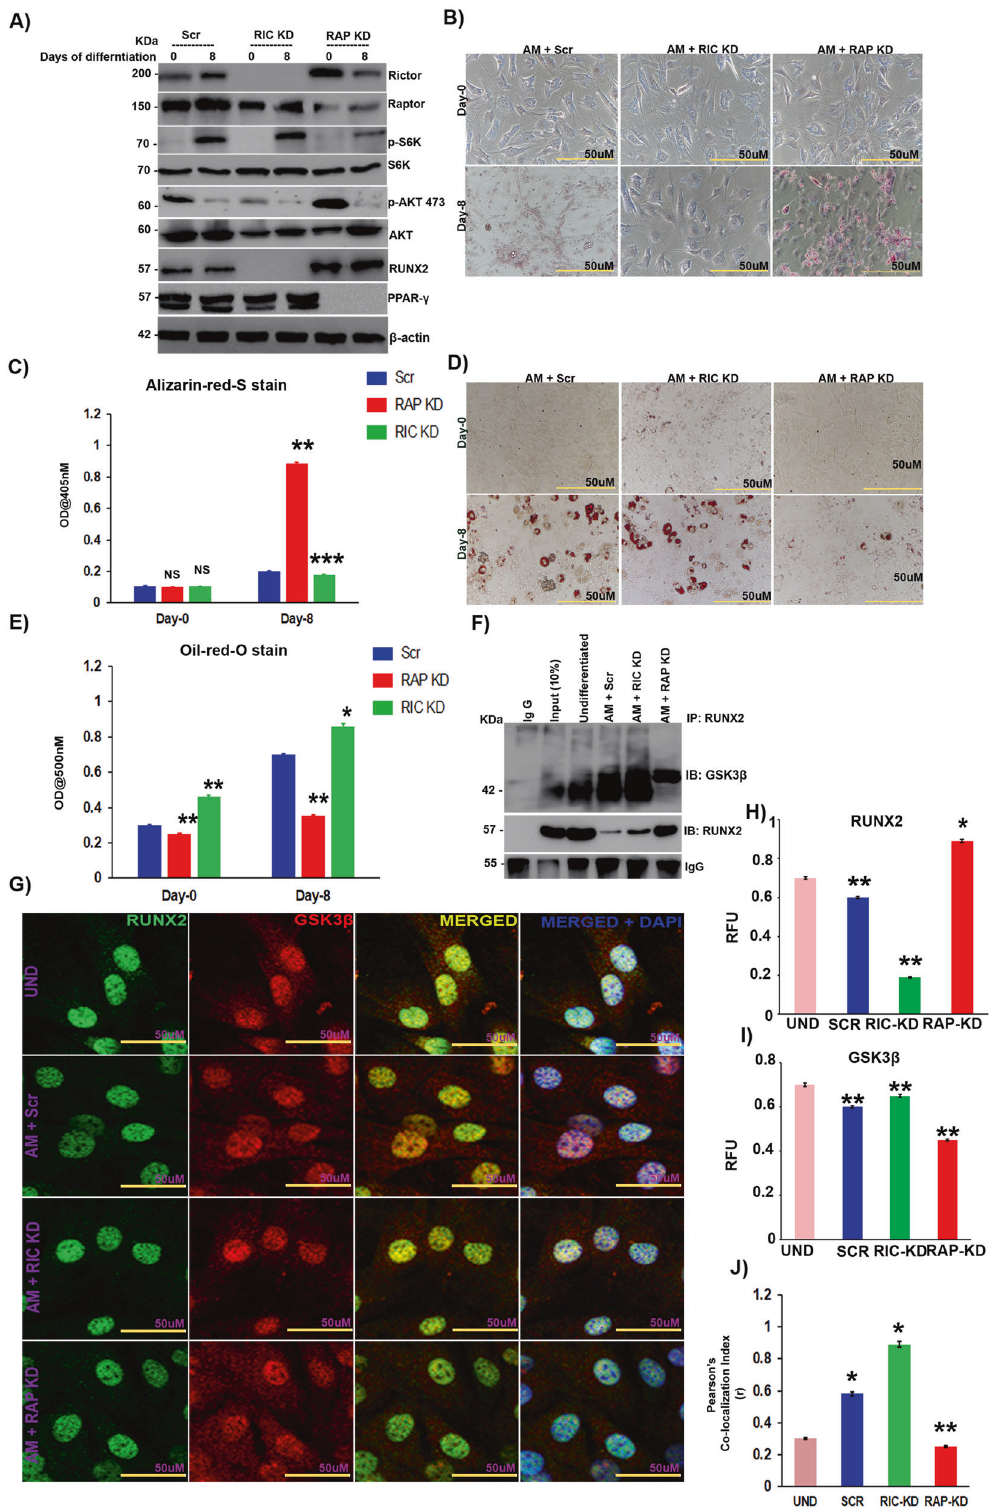
High glucose-induced glutamine sparing triggers RUNX2 loss under diabetic conditions Under high-glucose conditions, mTORC1 is hyperactivated, which results in feedback inhibition of mTORC2 through p-70S6K and fi nally a loss of RUNX2 protein levels; however, the mechanism behind hyperactivation of mTORC1 with increasing glucose Cell Death Discovery (2022)